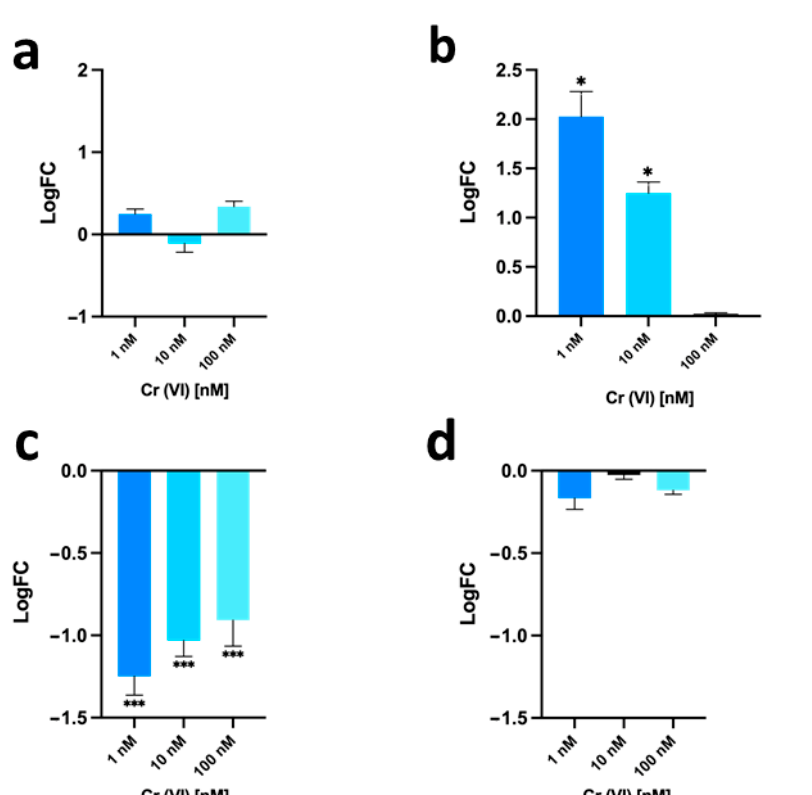
Figure 7. RT-qPCR of hsp70 , mt10 , PL-II / PL-IV and PL-III in M. galloprovincialis gonads. In the figure, the change in expression of hsp70 ( a ), mt10 ( b ), PL-II / PL-IV ( c ), and PL-III ( d ) is reported under the three chromium (VI) exposure conditions compared to the control condition (unexposed mussels). Expression was determined with respect to the housekeeping gene GAPDH . Values are presented as mean ± S.D. (n = 6). Asterisks indicate a statistically significant difference from unexposed mussels: * = p < 0.05; *** = p < 0.001.